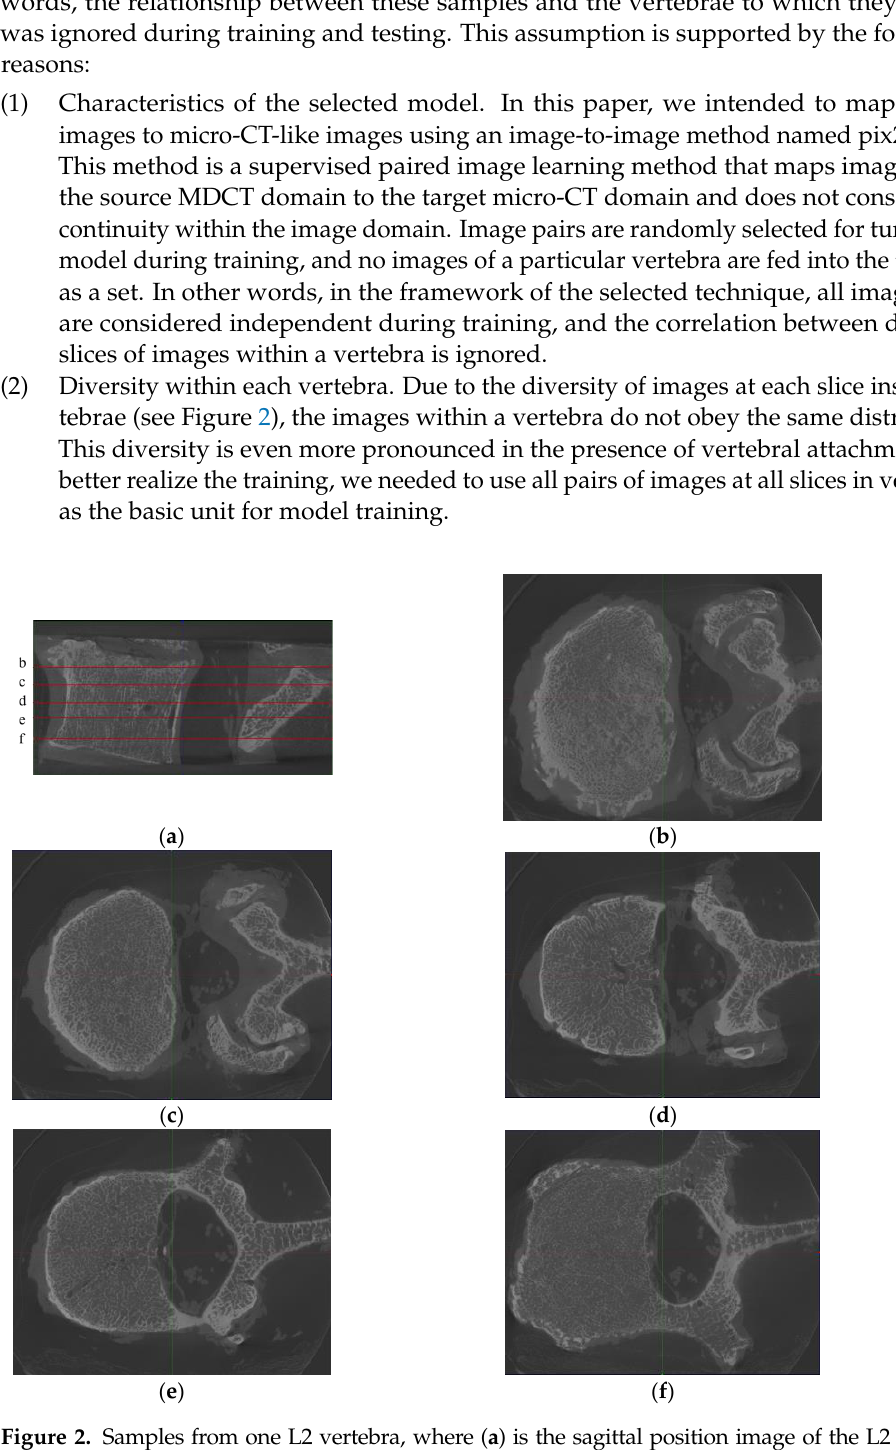
pairs were used as the training set (80%) [29]. Random sampling ensured that continuous information was removed, and the training and test sets covered most parts of the verte- brae so that the trained model did not suffer from underfitting or overfitting. In this way, the 12,500 image pairs in database_0 were divided into training (dataset_training) and test (dataset_testing) sets. 2.5. Model Training Pix2pixHD [24] is a model based on a CGAN that can generate high-resolution micro- CT-like images given the input MDCT images by finding the complex mapping function. The framework of pix2pixHD consists of a coarse-to-fine generator and multiscale dis- criminators. The coarse-to-fine generator contains a global generator network and a local enhancer network, where the global generator network focuses on coarse and global fea- tures of images (such as external contours and geometric structures) and the local en- hancer network focuses on local details (such as the texture and direction of bone trabec- ulae). Similar ideas but different architectures can be found in [30 – 32]. These multiscale discriminators are designed for training the coarse-to-fine generator using three identi- cally structured networks focusing on different scales of details. The network framework of the pix2pixHD model is shown in Figure 3.